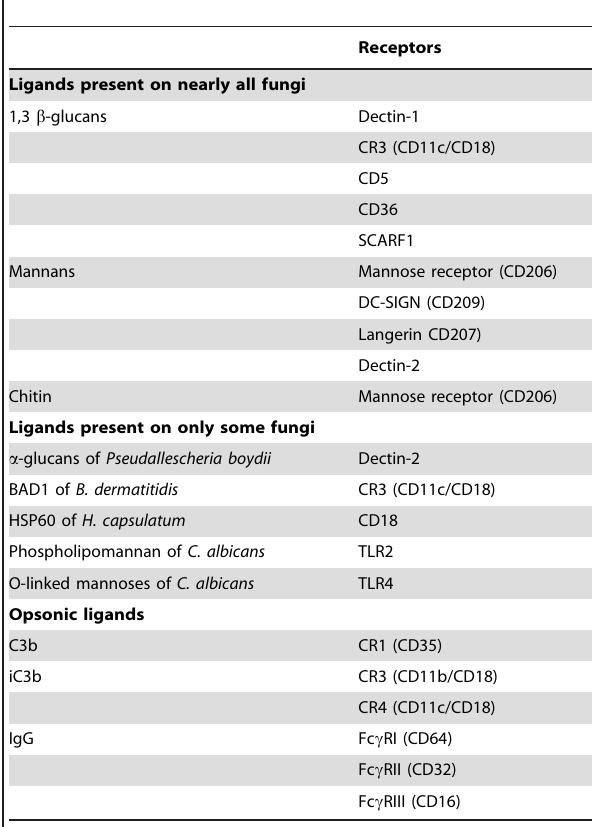
Table 1. Examples of Fungal Cell Wall Ligands and Their Cognate Phagocytic